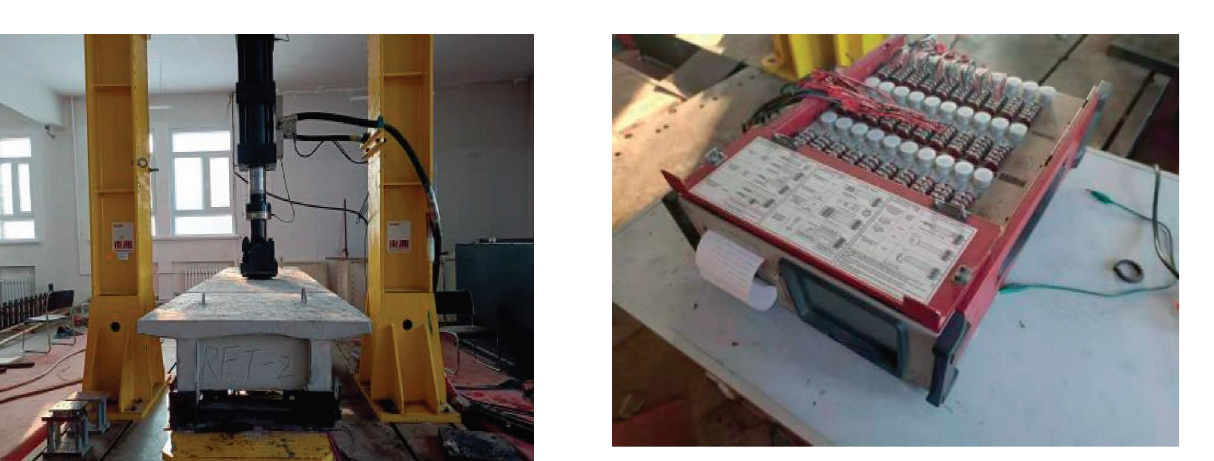
Figure 3: Japan TDS-530 data acquisition